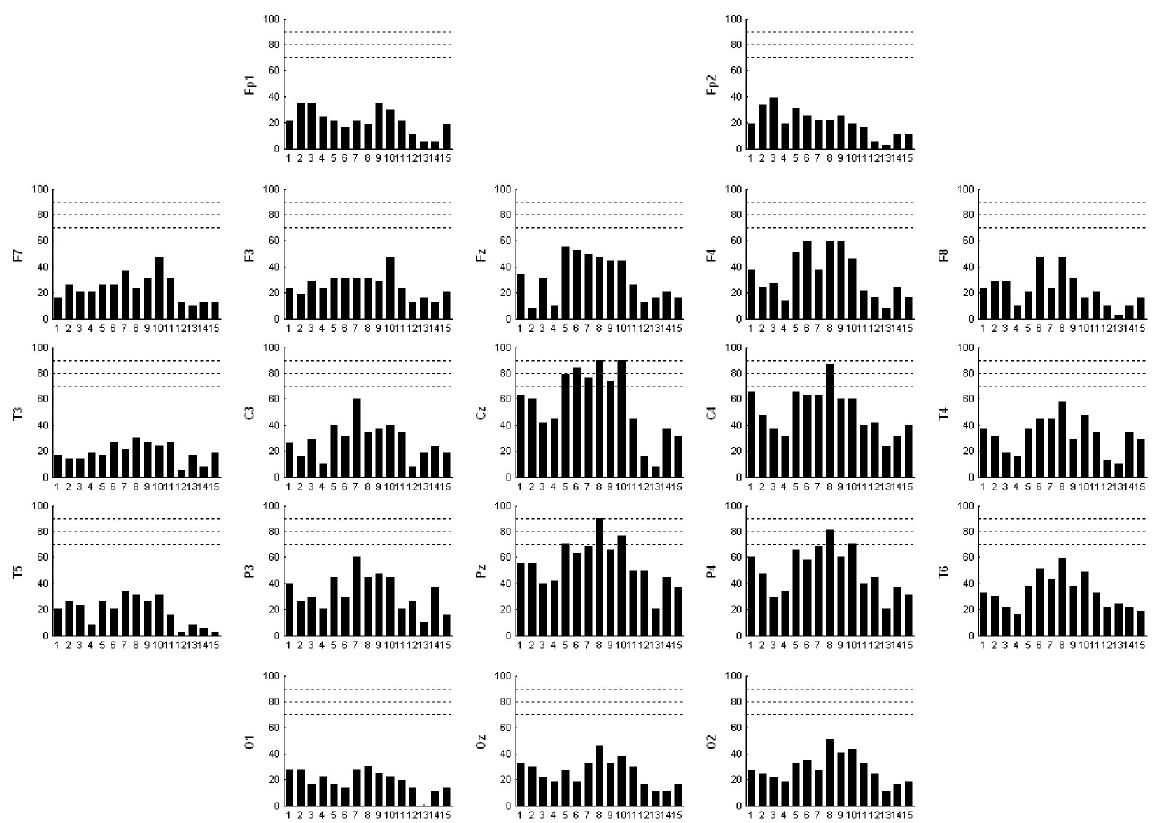
Figure 6. Bar graphics displaying the percentage of volunteers whose response to stimulation could be detected for the 1 st to 15 th multiples of the stimulation frequency (5 to 75 Hz). Horizontal lines indicate 70, 80 and 90% of detection. For derivations Fp1 (N = 37), Fp2 (N = 36), F4 (N = 37), T3 (N = 37), T6 (N = 37), O1 (N = 36), Oz (N = 37), and O2 (N = 37), it was not possible to obtain 500 artifact- free epochs for the 38 volunteers, hence, the percentages were calculated with the number of volunteers in